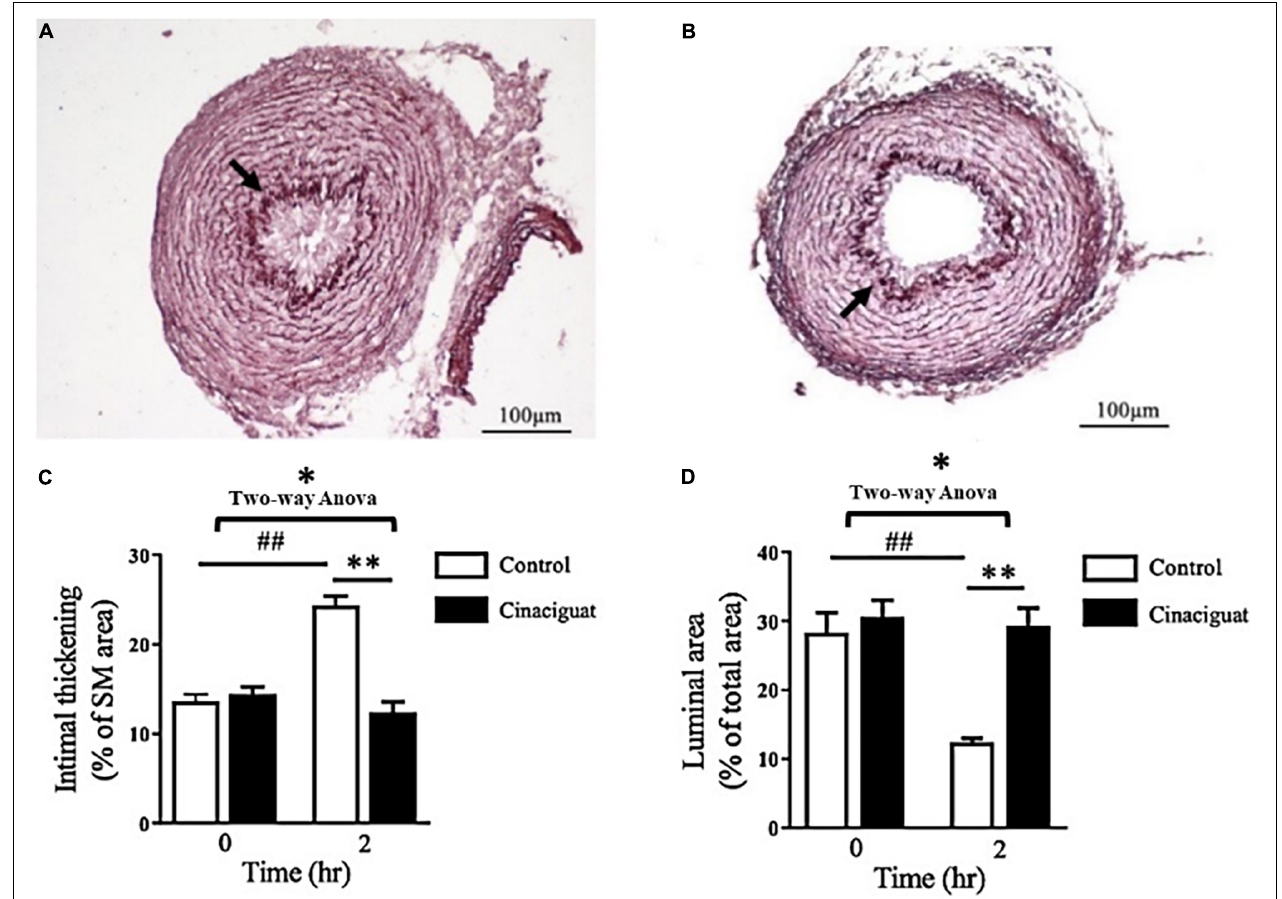
FIGURE 2 | Cinaciguat attenuated intimal thickening and maintained luminal patency of the ductus arteriosus (DA) in neonatal rats. (A,B) Histochemical analysis of DA section showed less intimal thickening and more luminal area in the (B) cinaciguat group compared with the (A) control group at 2 h after birth. Arrows indicate the internal elastic lamina separating the intimal layer from the medial layer. (C,D) The bar graphs show serial changes in the (C) intimal thickening and (D) luminal area in both groups. (C) In the control group, the intimal thickening (ratio of intima area/media area) increased significantly at 2 h compared with 0 h, while cinaciguat attenuated such increment at 2 h. (D) In the control group, the luminal patency (ratio of luminal area/total vessel area) was attenuated significantly at 2 h compared with 0 h, while cinaciguat preserved luminal patency at 2 h. SM, smooth muscle. Values represent the mean ± SEM; N = 6. * P < 0.05 by the two-way ANOVA analysis; ## and ** P < 0.01 by the post hoc test; magnification 200 × .